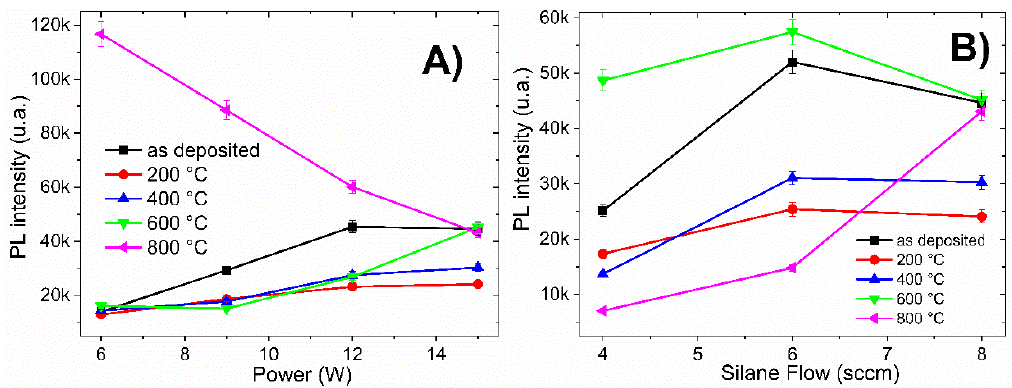
Figure 8. PL intensity of a-Si 1 − x C x :H films deposited: ( A ) with di ff erent RF power (6–15 W) maintaining constant R 0 ratio (37.5); and ( B ) with di ff erent R 0 ratios (37.5–75) and fixed RF power (15 W).